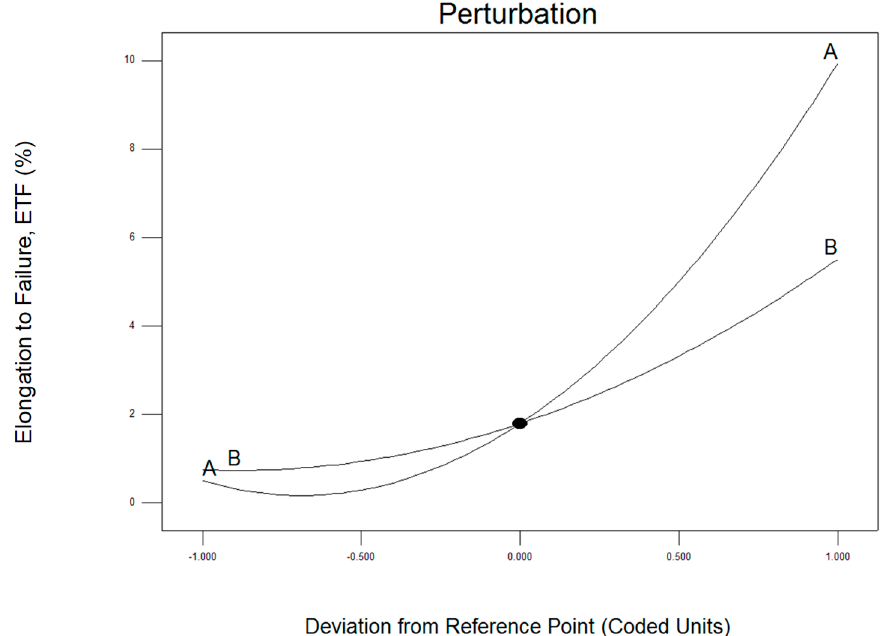
Figure 5. Perturbation plotted graph as a correlation of ( A ) operating temperature and ( B ) holding time for elongation to failure (ETF).